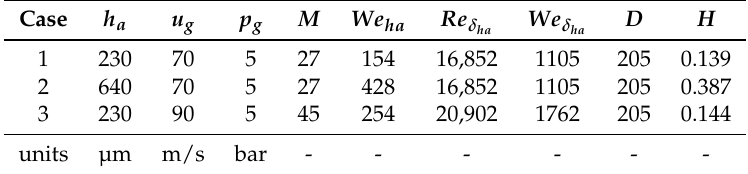
Table 1. Non-dimensional quantities describing prefilming airblast atomization (c.f. Appendix